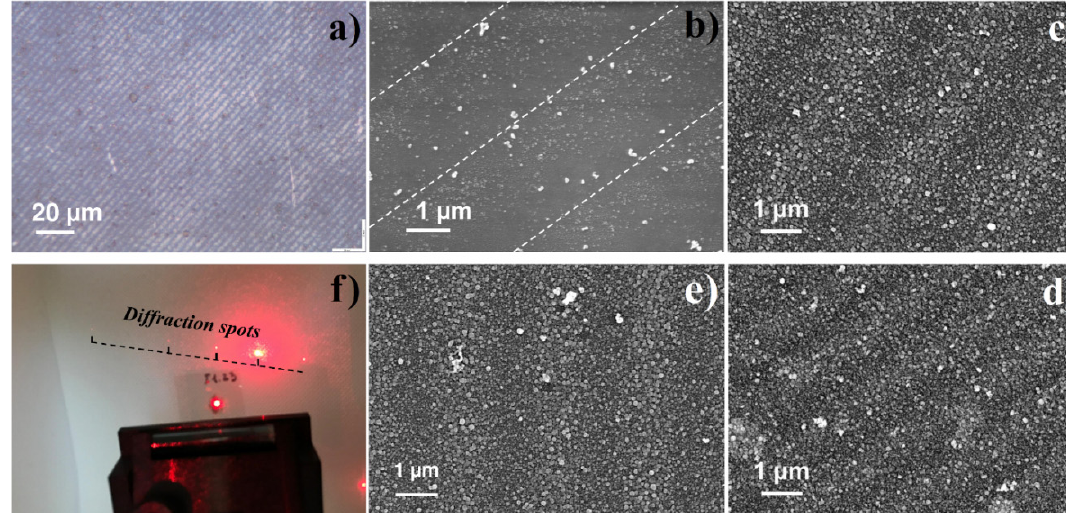
Figure 9. Micrograph and SEM analysis of Ag NPs grating with different synthesis conditions: ( a , b ) laser power of 200 mW, irradiation time 2 min, period 375 lines/mm; ( c ) laser power of 45 mW, irradiation time 20 min, period 375 lines/mm; ( d ) laser power of 45 mW, irradiation time 40 min, period 750 lines/mm; ( e ) laser power of 200 mW, irradiation time 10 min, period 375 lines/mm; ( f ) demonstration of diffraction effect on Ag NPs grating deposited under laser power of 200 mW, irradiation time 10 min, period 375 lines/mm.